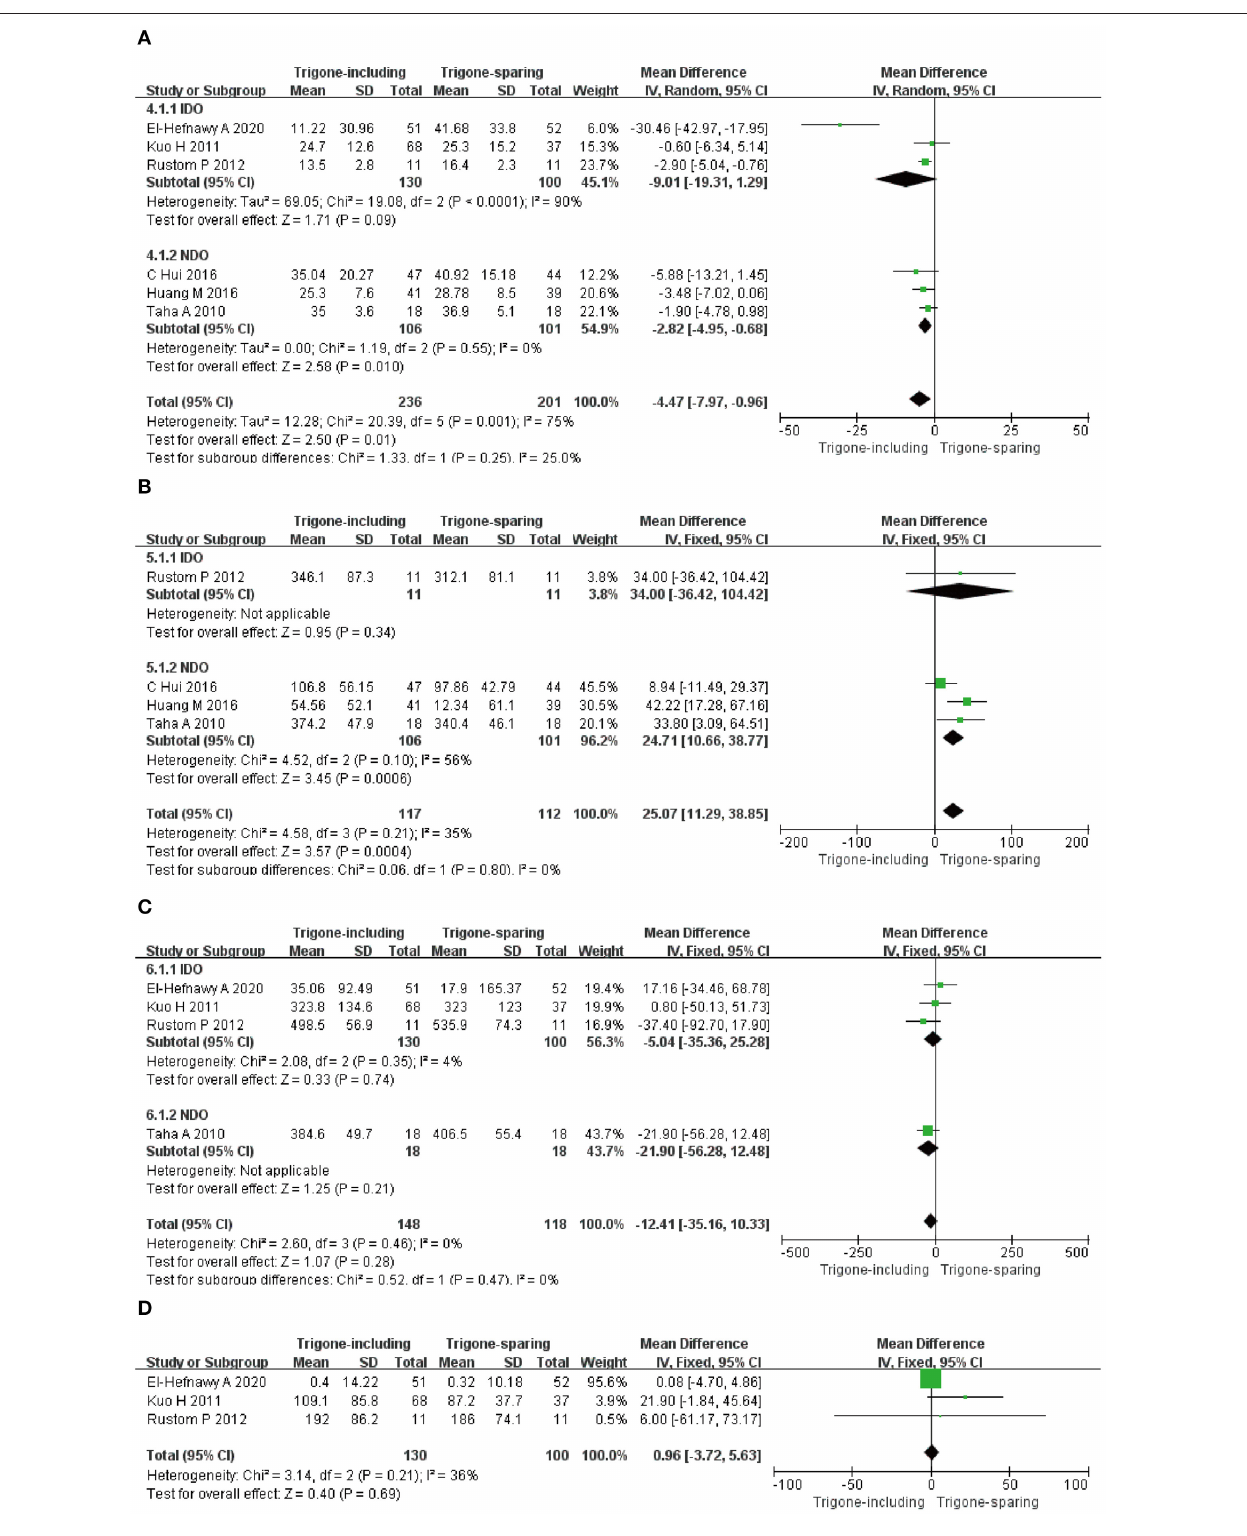
FIGURE 5 | Forest plots showing changes between two groups in (A) impact on detrusor pressure at maximum flow rate, (B) impact on volume at the first desire to void, (C) impact in maximum cystometric capacity, (D) impact on post-void residual volume; NDO, neurogenic detrusor overactivity; IDO, idiopathic detrusor overactivity; SD, standard deviation; IV, inverse variance; CI, confidence interval; df, degrees of freedom.